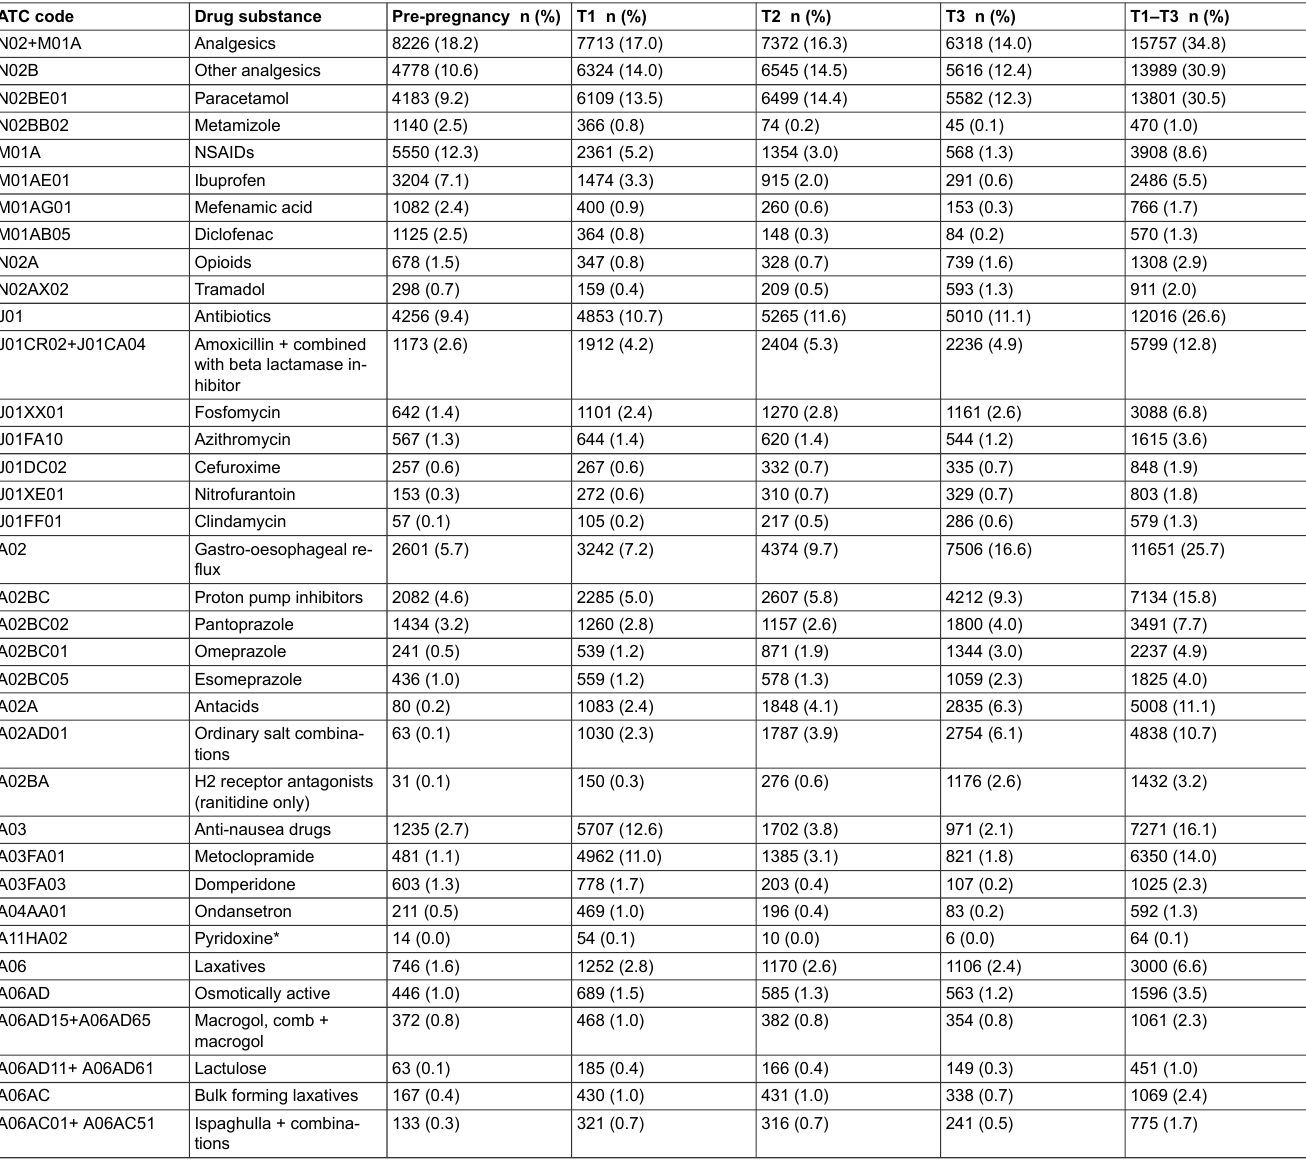
Table S3: Exposure prevalence to different drug groups and active substances during pregnancy overall and within trimester of pregnancy and pre-pregnancy separately (crude numbers). ATC code